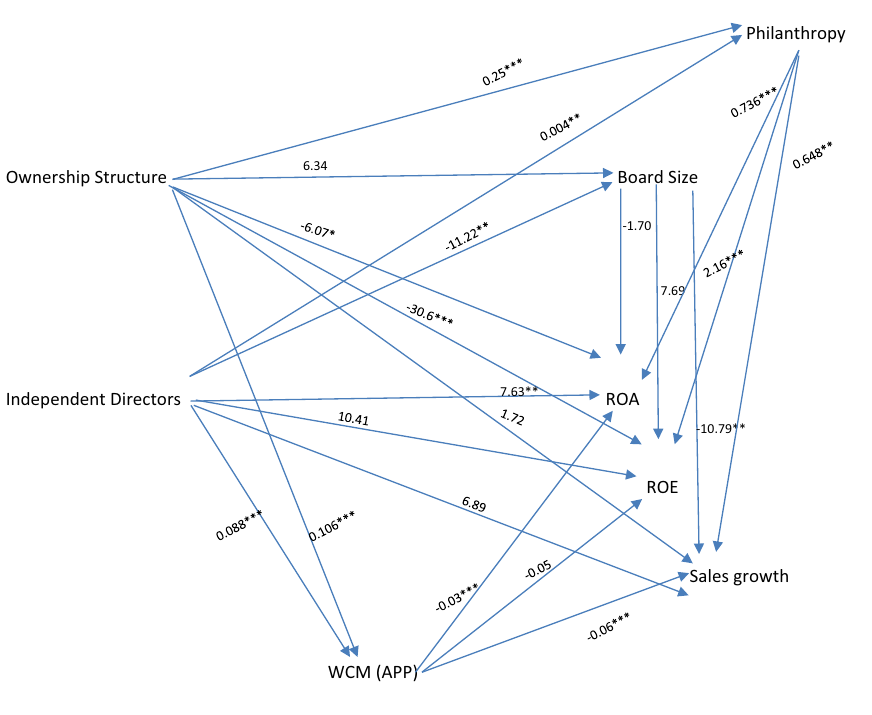
Figure 2. Results of